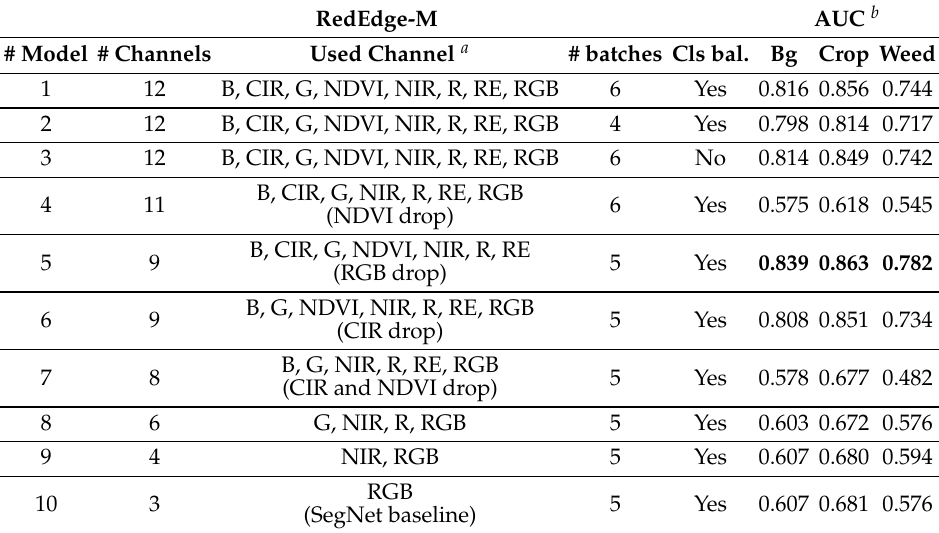
Table 5. Performance evaluation summary for the two cameras with varying input